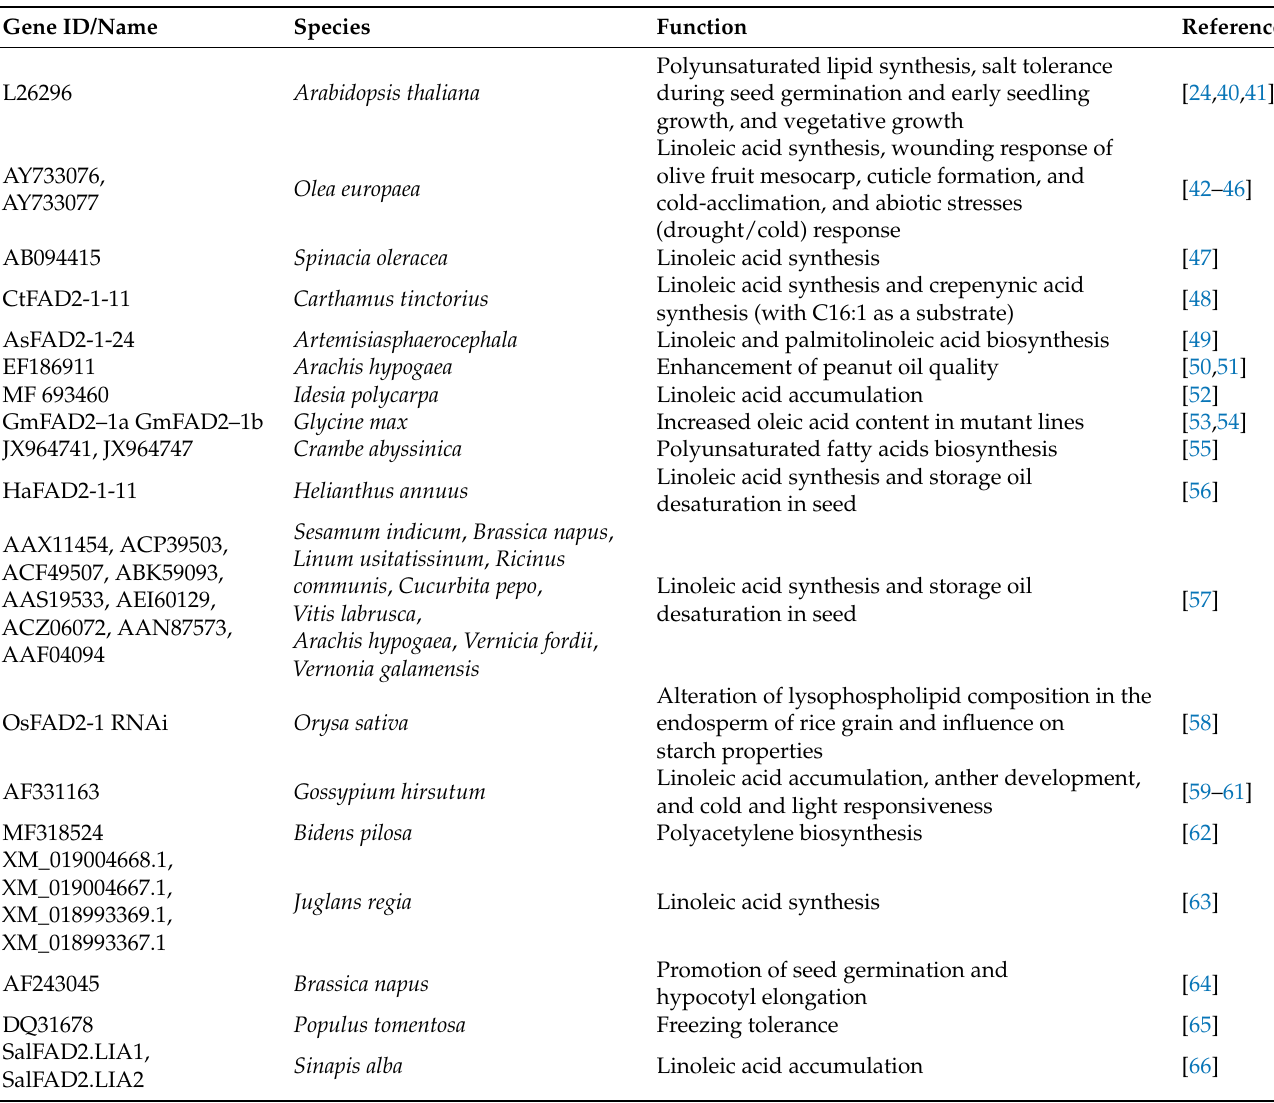
Table 2. Different functions and biological roles attributed to FAD2 enzymes within several species through biological engineering and polymorphism